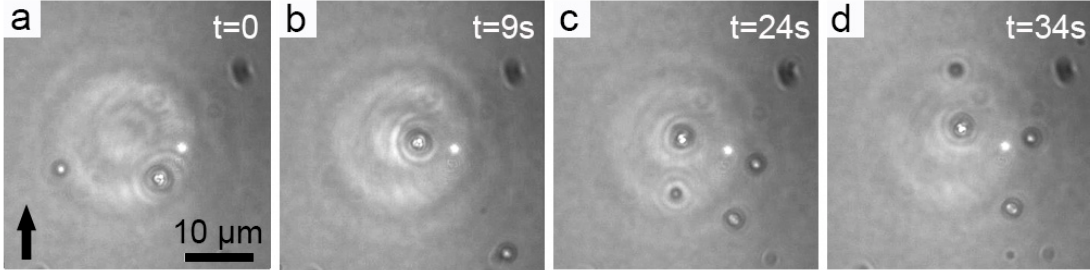
Figure 9. A video sequence showing ( a,b ) an NLC droplet moving upward due to heat convection and was trapped by metalens based laser tweezers. ( c,d ) The trapped droplet remained in the laser focus while others in the background kept flowing upward.